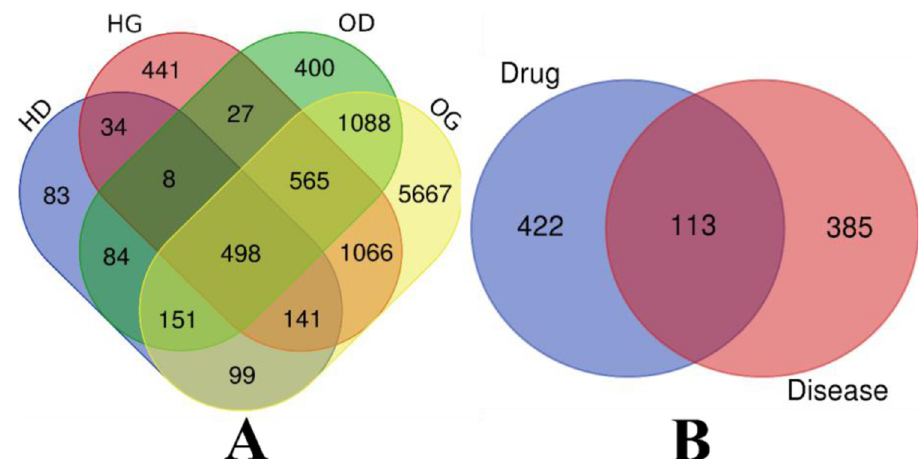
Fig 1. Venn diagram representing the (A) genes related to hyperglycemia with obesity by the union of DisGeNet and GeneCards. (B) identification of drug-target disease-related genes. Note : H: Hyperglycemia, O: Obesity, D: DisGeNet, G: GeneCards.